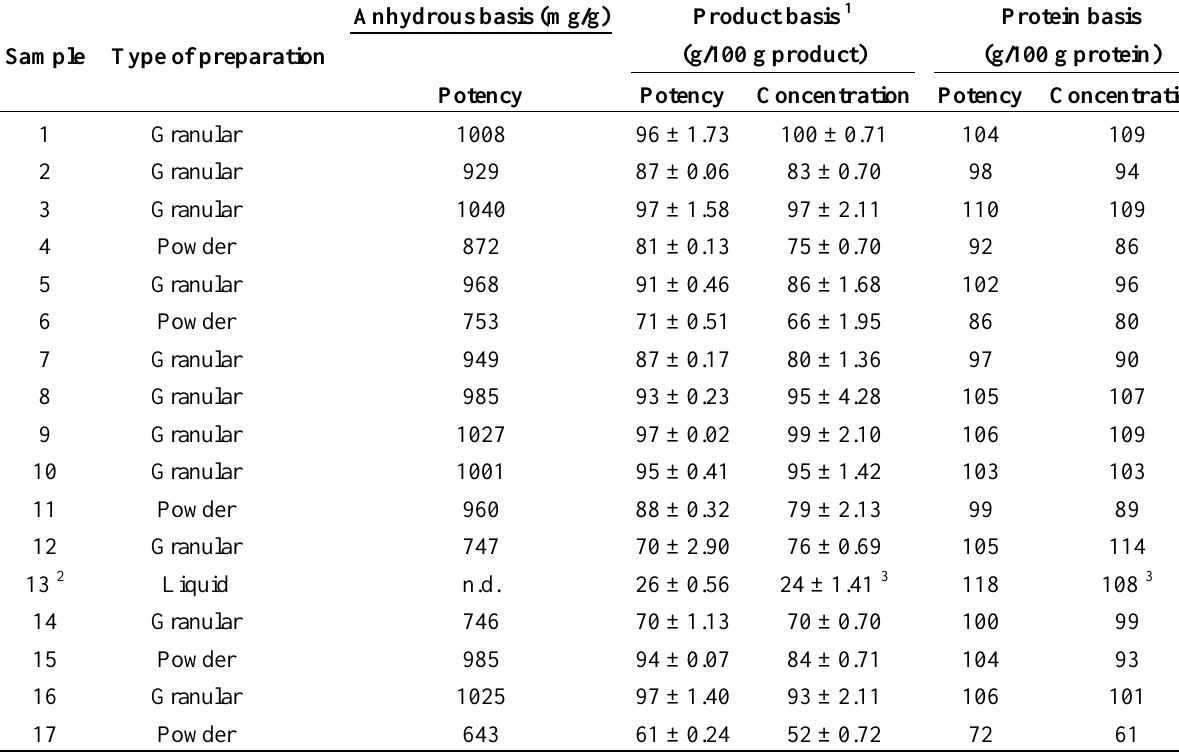
Table 2. Potency (microbiological activity) and concentration (HPLC) of lysozyme in the commercial